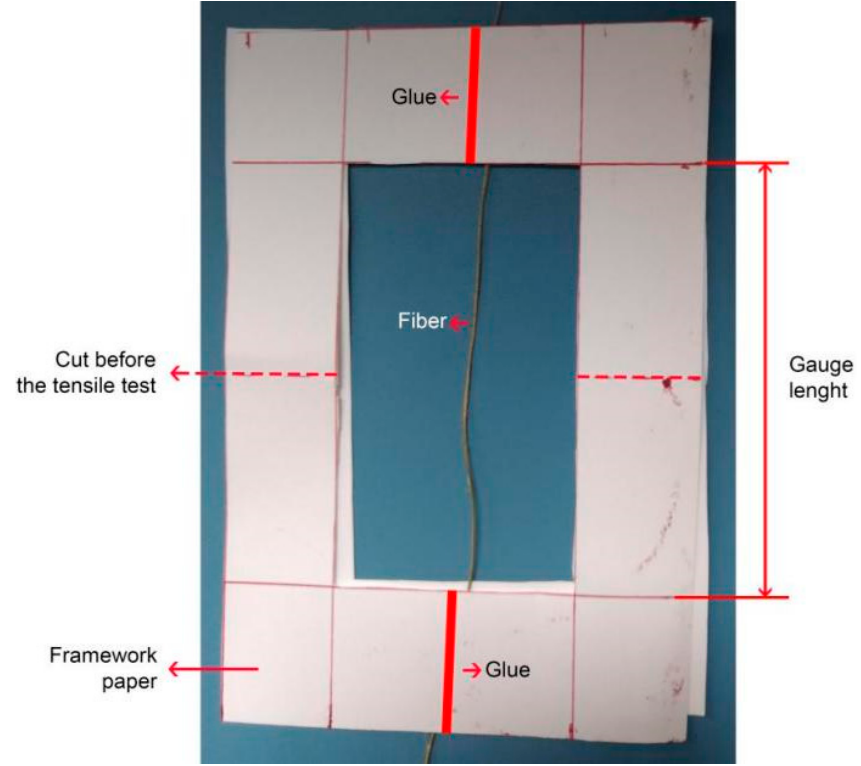
Figure 2. Apparatus used for the tensile test of sedge fibers. The tensile strength values obtained were statistically interpreted by the Weibull Analysis software, which provided the corresponding scale parameter ( θ ), shape parameter ( β ), and precision fit parameters (R 2 ). The software is based on the cumulative Weibull frequency distribution function ( F ( x )), given by Equation (3), in which β is a linear slope.